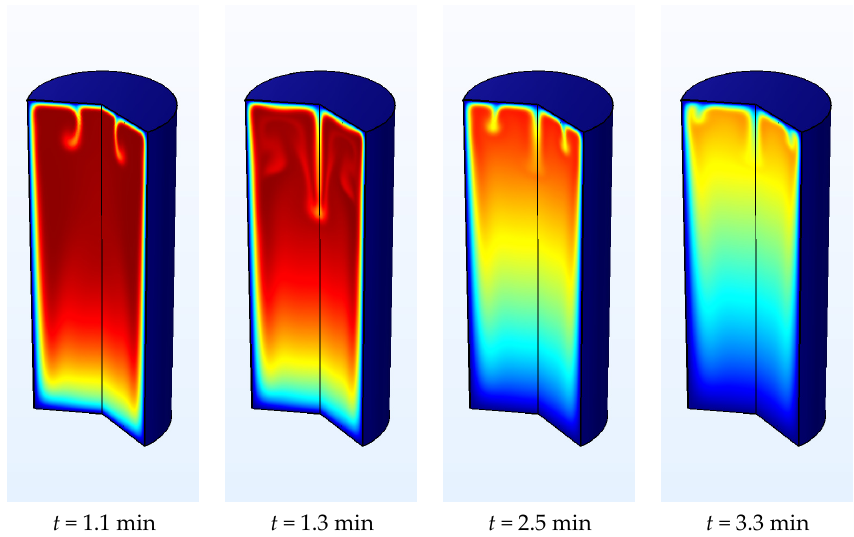
Figure 6. Temperature distributions in the cylinder; top: Heating stage, bottom: Cooling for T 0 = 22 °C (blue) and T 1 = 95 °C (red).